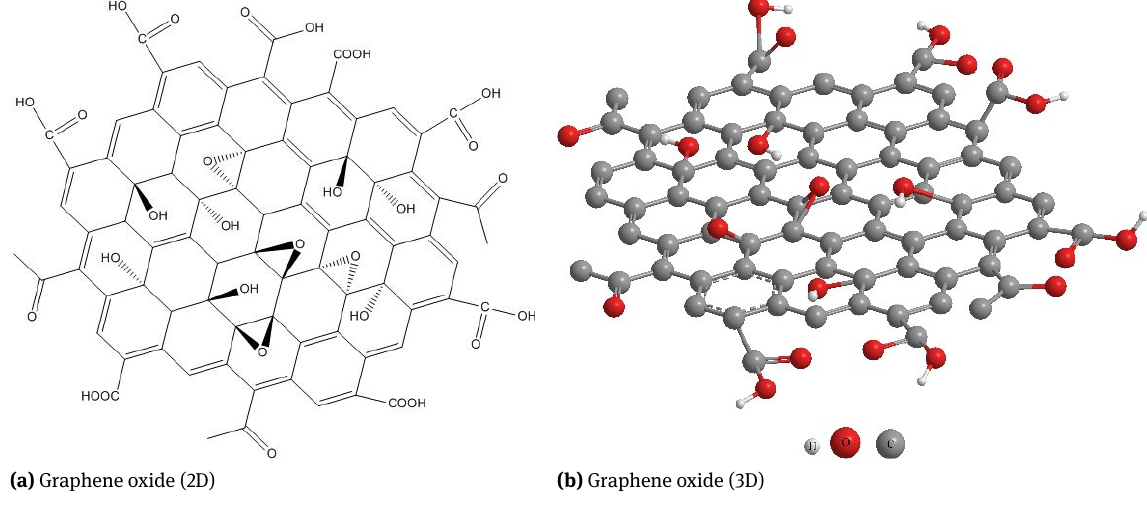
Figure 1: The structure model of GO Table 1: Technical indicators of SK-90